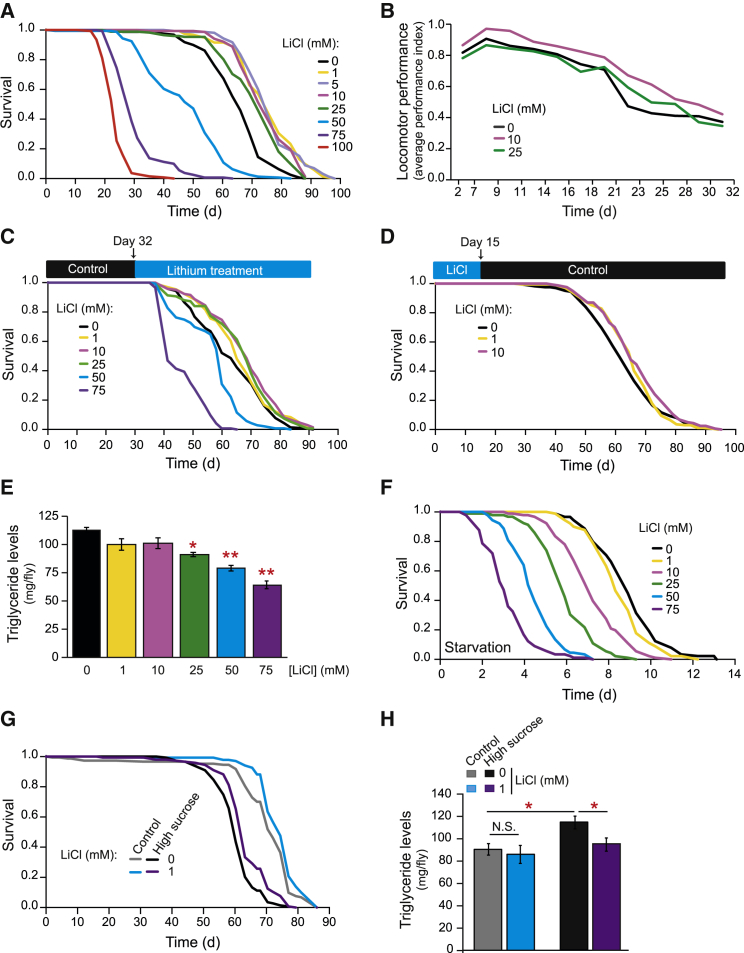
Lithium Regulated Longevity and Metabolism in Drosophila(A) Lithium extended lifespan of wDahDrosophila females (n = 160 flies per condition) at concentrations between 1 and 25 mM (+16% and +18% median and maximum lifespan extension; p < 0.001), but resulted in a dose-dependent reduction in lifespan at concentrations between 50 and 100 mM (p < 0.001).(B) Lithium treated female w1118 flies showed a significant improvement and protection against age-related locomotor decline (p < 0.01, two-way ANOVA for 10 mM).(C) Lithium extended lifespan of aged, 32-day-old female wDah flies at concentrations from 1 to 25 mM (30 days later than in Figure 1A): 1 mM extended median lifespan by 5% (4 days) and maximum lifespan by 13% (8 days; p < 0.05); 10 and 25 mM lithium increased median lifespan by 9% (6 days); 10 mM increased maximum lifespan by 4.5% (3.5 days); wherease 25 mM lengthened it by 8% or 6 days (p < 0.01); and 50 and 75 mM significantly shortened lifespan (p < 0.01). n = 150 flies per condition.(D) Brief treatment with lithium for 15 days early in adulthood extended lifespan of female wDah flies (p < 0.05 for 1 mM and p < 0.01 for 10 mM; n = 150 flies per condition).(E) Lithium induced a dose-dependent reduction in triglyceride levels. Bars represent means of six replicas of five flies per condition ± SEM. ∗p < 0.01, ∗∗p < 0.001.(F) Female wDah flies pre-treated with lithium for 15 days were subsequently sensitive to starvation in a dose-dependent manner (n = 90 flies per condition).(G) Lithium treatment significantly extended the lifespan of w1118 female flies exposed to a four times higher sucrose concentration (2g/L; p < 0.001; n = 120 flies per condition).(H) The increase of triglycerides observed on a high-sucrose diet was completely blocked after 15 days of treatment with 1 mM lithium. Bars represent means of six replicas of five w1118 female flies per condition ± SEM. ∗p < 0.01.